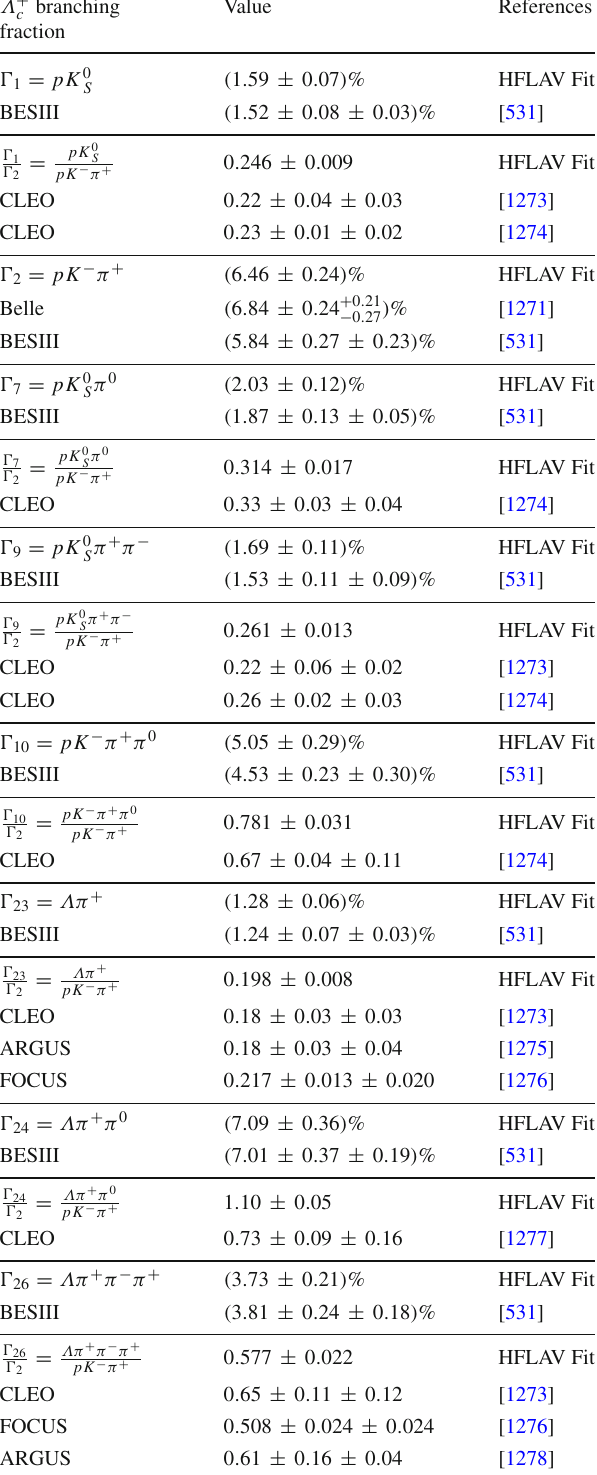
Table296 Experimentalresultsandworldaveragesforbranchingfrac- tionsoftwelvehadronicandonesemileptonic Λ + c decay.Thefirstuncer- tainty is statistical and the second is